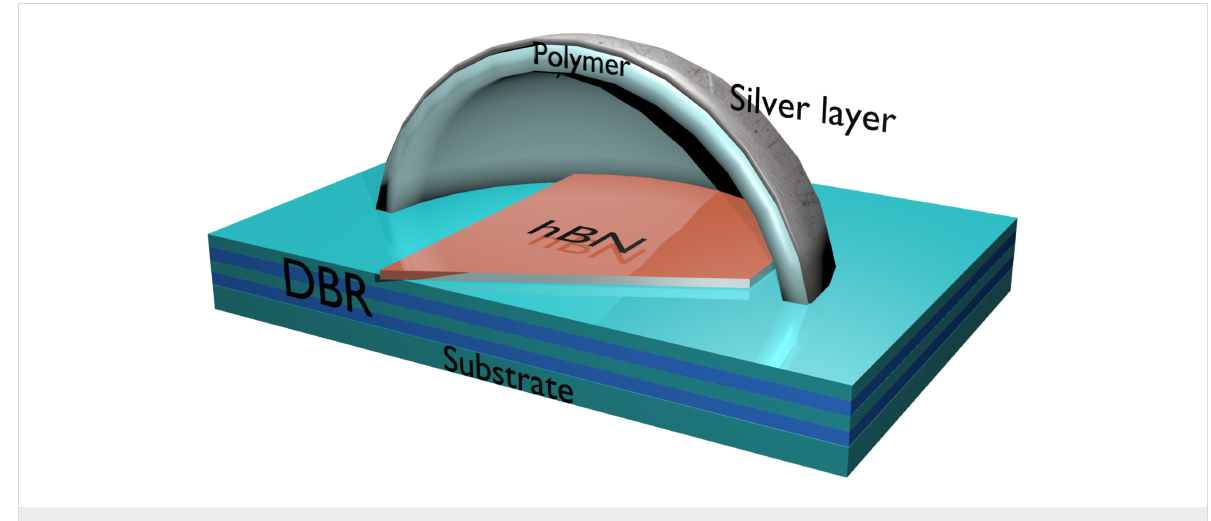
Figure 1: Conceptual design shows cross-section of hybrid plano-concave microcavity with a 2D hBN layer inside on top of a distributed Bragg reflector